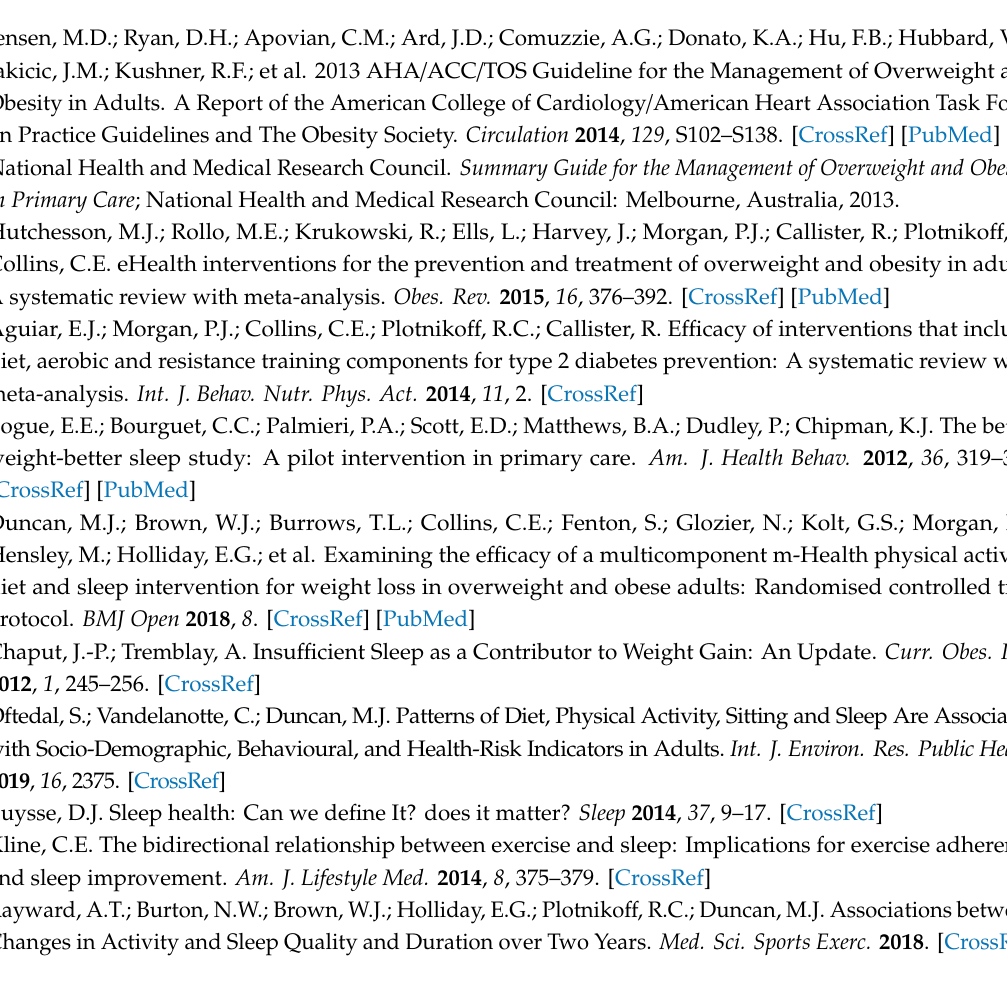
Intervention Groups, Table S4: Weight, cardiovascular risk factors, lifestyle behaviours, and mental health characteristics at baseline, 6 month and 12 month health Traditional & Enhanced Groups, Table S5: Sensitivity analyses using multiply imputed data (10 imputations); Baseline adjusted group di ff erences between Pooled and Control Groups at 6 months and 12 months, Table S6: Sensitivity analyses using multiply imputed data (10 imputations). Baseline adjusted group di ff erences between Enhanced and Traditional Groups at 6 months and 12 months, Table S7: System Usability Scores for Move, Eat & Sleep participants using the Balanced App at 6